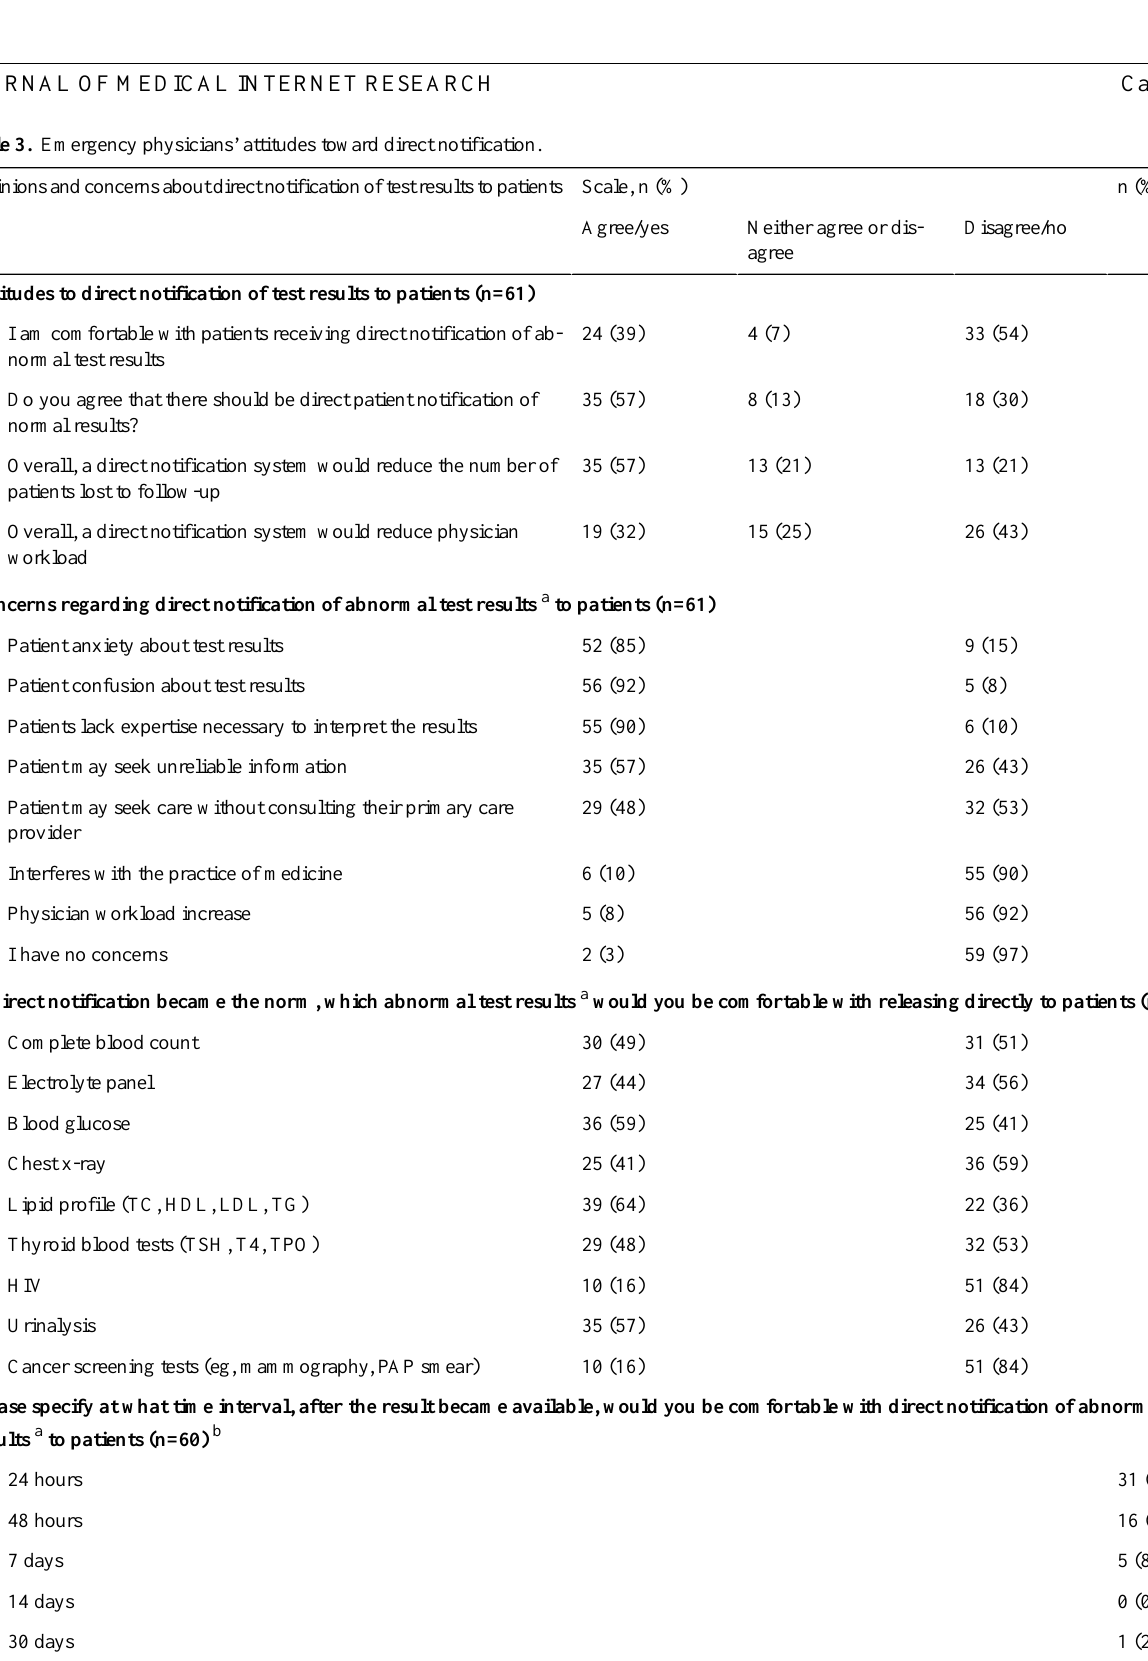
Disagree/noNeither agree or dis- agreeAgree/yes